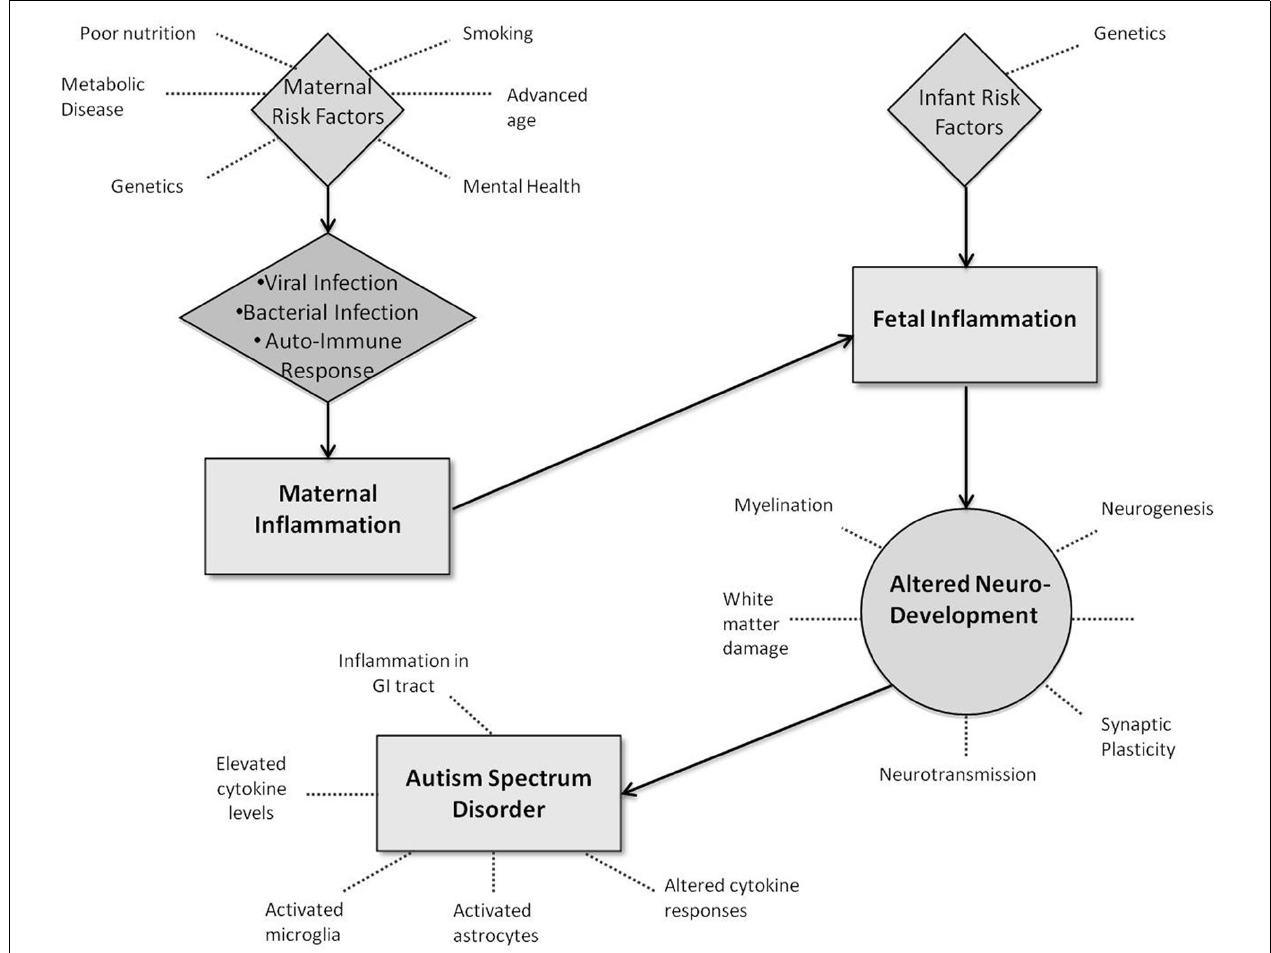
FIGURE 1 | Potential interactions between infection-led inflammation and neurodevelopment in Autism Spectrum